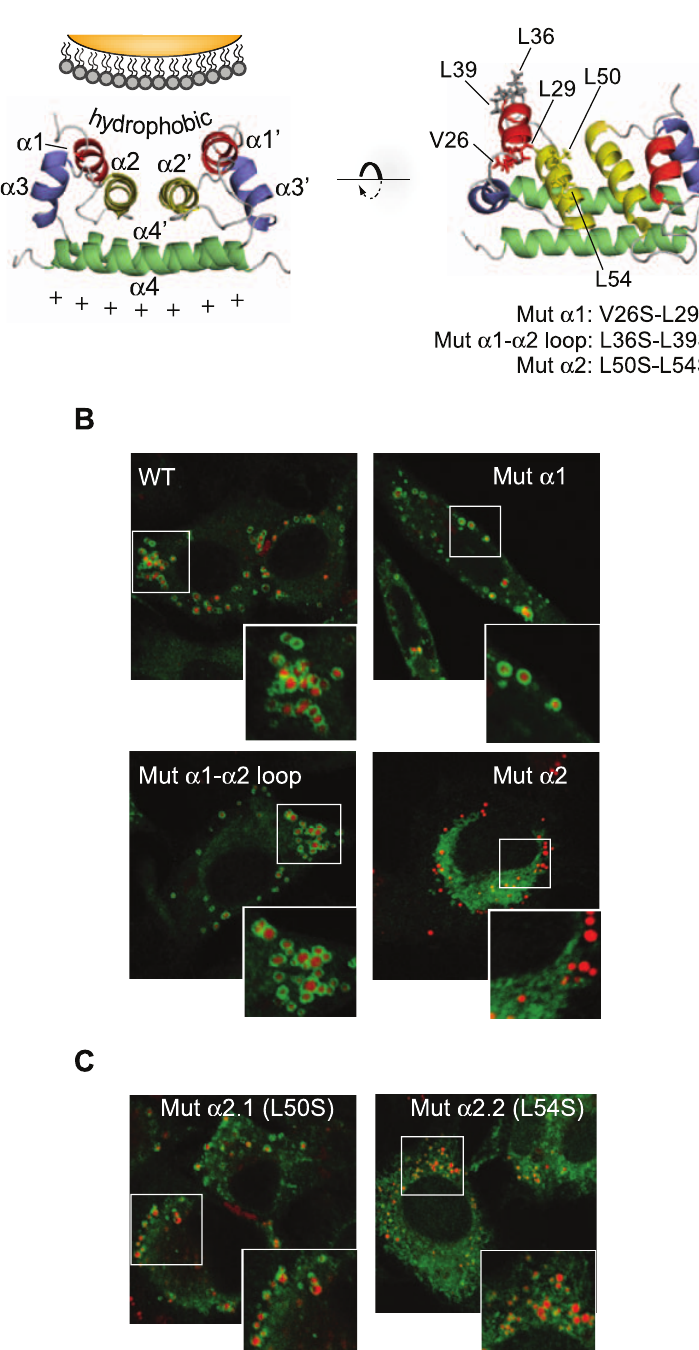
Figure 3. Amino acids within the a 2 helix of C are necessary to direct the protein to LDs. A. Ribbon diagram of the dimer structure of DENV C protein [25]. The four a helices ( a 1 to a 4) are indicated in each monomer. The hydrophobic cleft proposed to interact with membranes is also shown. On the right, the location of amino acids that were mutated in the DENV infectious clone is indicated in the structure (Mut a 1, Mut a 1– a 2 loop, and Mut a 2). B. Distribution of the C protein and lipid droplets in cells transfected with mutated DENV RNAs. BHK cells transfected with the WT or mutated RNAs containing the substitutions indicated in A were analyzed by immunofluorescence and confocal microscopy. The C protein and lipid droplets were localized by anti-C antibodies (green) and BODIPY (red), respectively. C. Amino acids L50 and L54 are necessary for targeting C to LDs. BHK cells transfected with DENV RNAs carrying the individual substitutions L50S (Mut a 2.1) or L54S (Mut a 2.2) were used to analyze the localization of the mutated C proteins and LDs as described above.